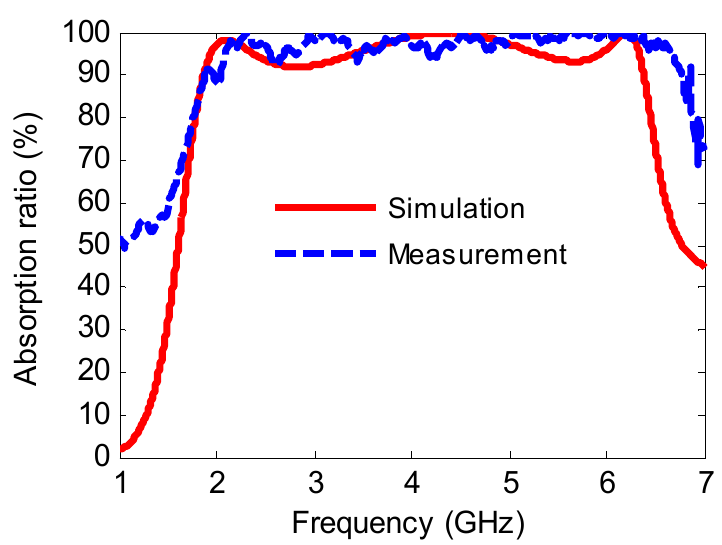
Figure 10. Measured and simulated absorption coefficient. Table 1. Comparison with other wideband MS absorbers having air layer and loaded with lumped resistors.